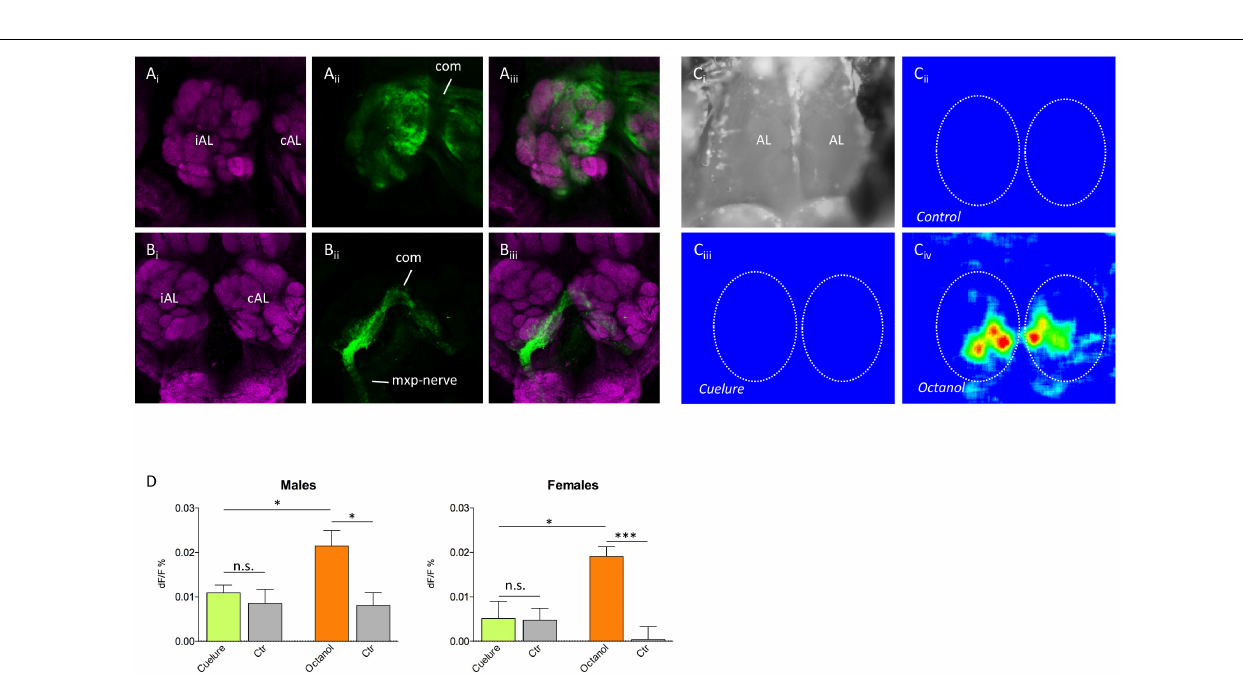
FIGURE 3 | Antennal lobe innervation and odor-evoked activity. Tracing of (A i –A iii ) antennal and (B i –B iii ) maxillary palp innervation in the antennal lobe (magenta, anti-synapsin staining; green, neurobiotin tracing). The iAL (ipsilateral) is the antennal lobe on the same side as the traced nerve, whereas the cAL (contralateral) only receives innervation via the commissure (com). Maxillary palp nerves (mxp-nerve) only innervate four to five glomeruli in the ventromedial part of both lobes, whereas antennal nerves innervate the remaining about 50 glomeruli. (C i –C iv ) False color coded Ca 2 + imaging responses to control, cuelure, and octanol, respectively. Panel (C i ) shows a grayscale image of the area of the brain recorded from, while panels (C ii –C iv ) show the relative change in activity (d F / F ) during stimulation in a single male individual. In panels (C ii –C iv ) , the outlines of the antennal lobes are depicted by the dotted lines. The responses in panels (C ii –C iv ) have identical intensity scales. (D) Mean ± SEM of the relative change in activity during odor stimulation. For cuelure and octanol, the response in the strongest activated glomerulus was used and compared with a solvent control response (paraffin oil). n.s., not significant, ∗ P < 0.05, ∗∗∗ P < 0.001 (unpaired t -test).